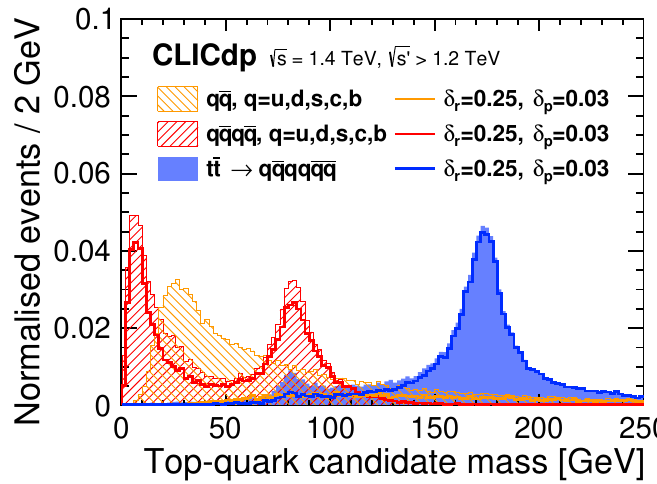
p s = 1 : 4 TeV for events with p